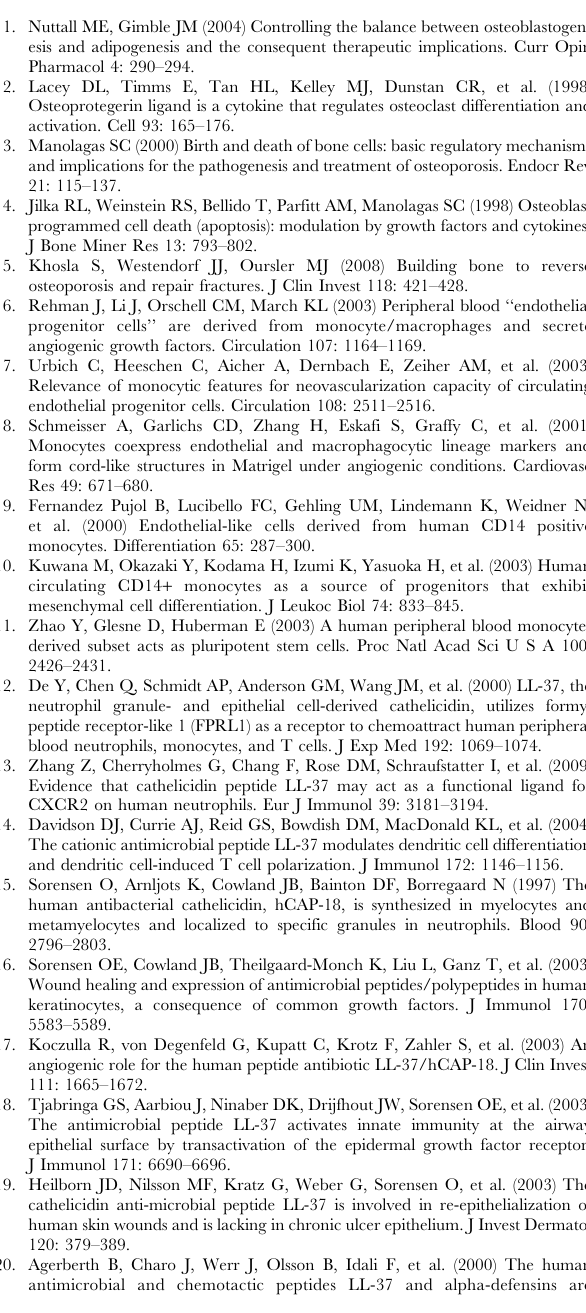
Table S1 Comparison of cytokine release of LL-37-differentiat- ed cells for 6 days with medium, LPS, GM-CSF, and M-CSF differentiated macrophages (Mean 6